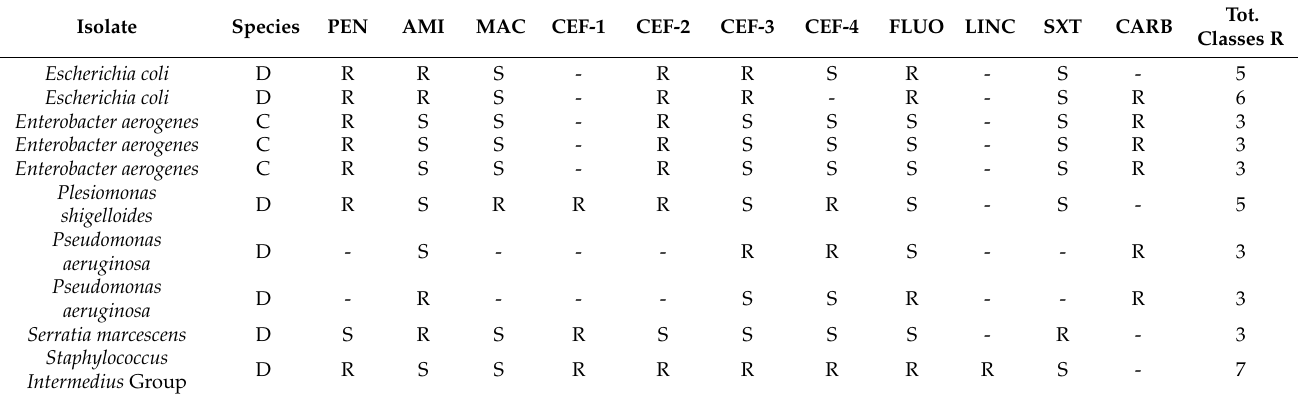
Table 6. Phenotypic resistance profiles of multiresistant